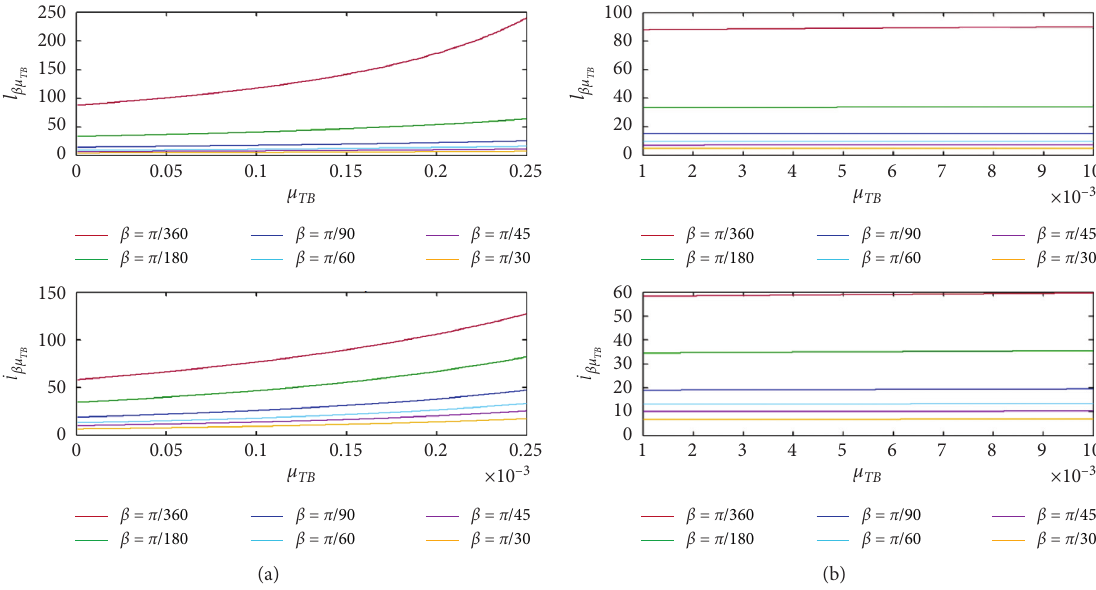
Figure 7: The relationship of the gravity block length l the stability angle ϕ � ( π /4 ) and different well inclination angles β